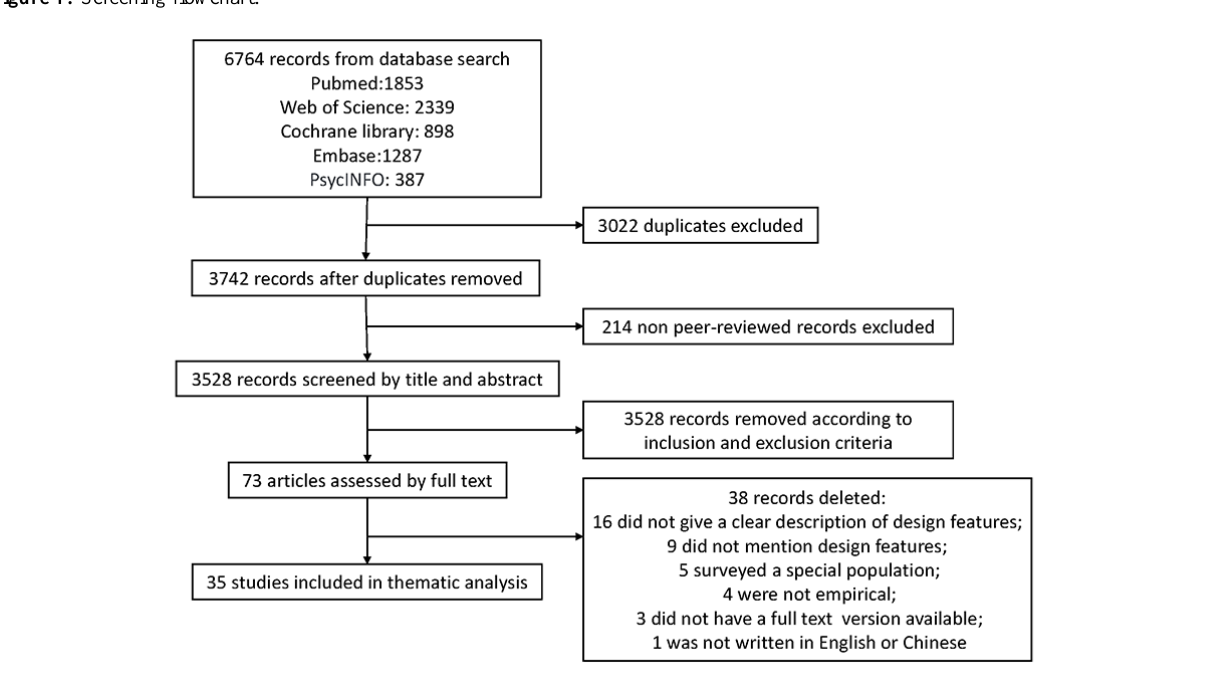
Figure 1. Screening